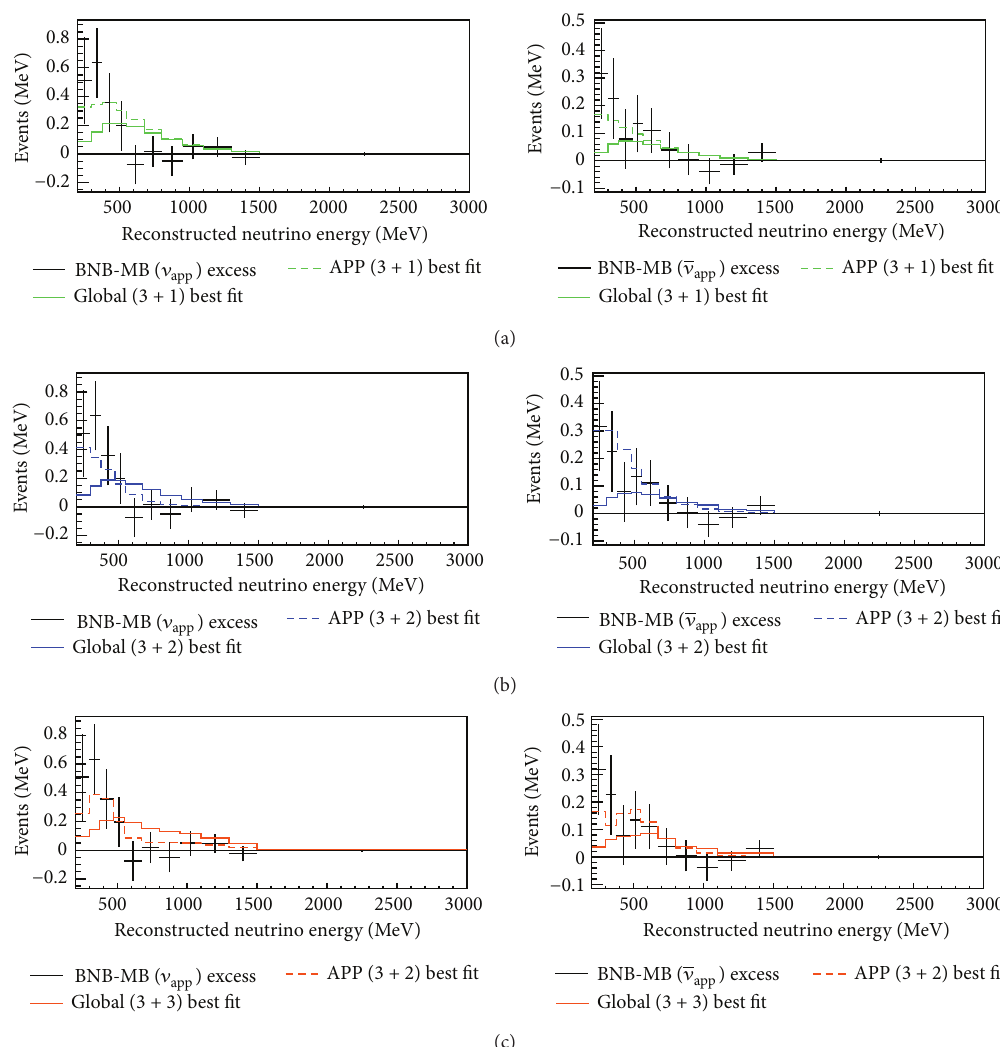
Figure 13: A comparison of the BNB-MB( 𝜈 ) and BNB-MB( 𝜈 ) excess data with the global best-fit oscillation signal predictions (solid app app colored lines) and with the appearance only best-fit predictions (dashed colored lines) for each of the models, ( 3+1 ), ( 3+2 ), and ( 3+3 ). The error bars on the excess correspond to statistical and unconstrained background systematic errors, added in